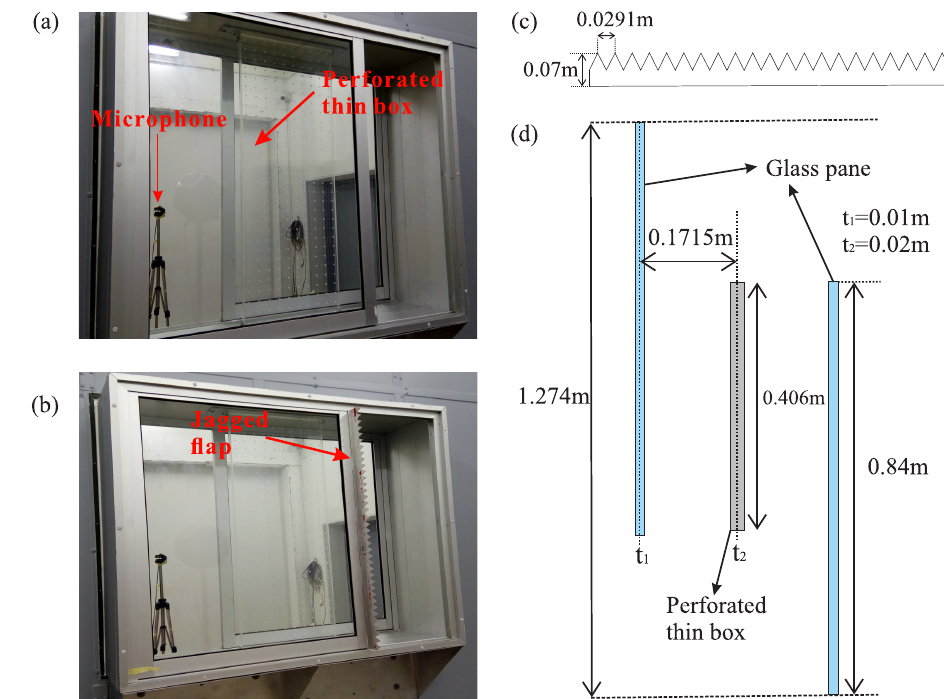
Figure 1. ( a ) Experimental set-up of the plenum window with perforated thin box at reverberation room. ( b ) Plenum window with attached 90 ◦ jagged flap. ( c ) Geometry of the jagged flap. ( d ) Schematic diagram of the experiment set up (top view, t = thickness, detailed geometry of the perforated thin box is shown in Figure